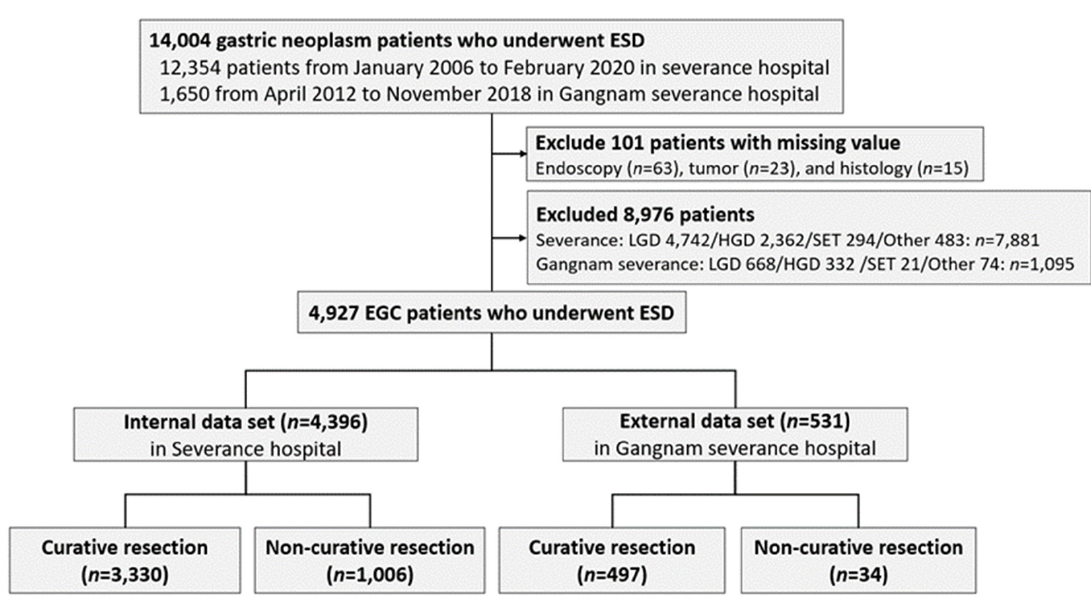
Figure 1. Flow diagram of study design. Abbreviations used are EGC, early gastric cancer; ESD, endoscopic submucosal dissection; LGD, low-grade dysplasia; HGD, high-grade dysplasia; and SET, subepithelial tumor. Table 1. Clinical variables used to build machine-learning models.